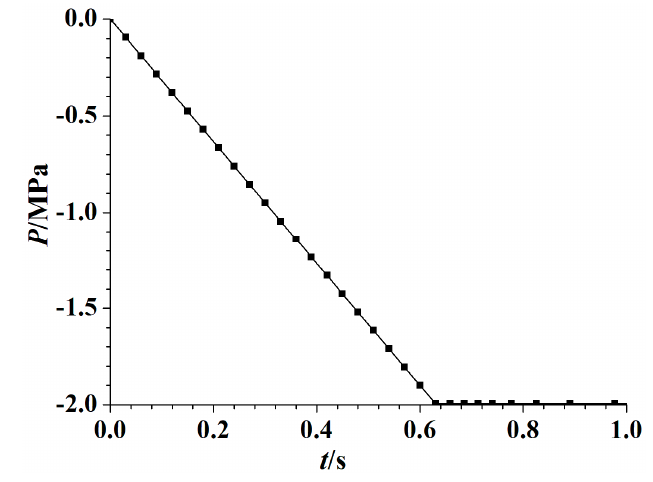
Figure 4. Comparison of